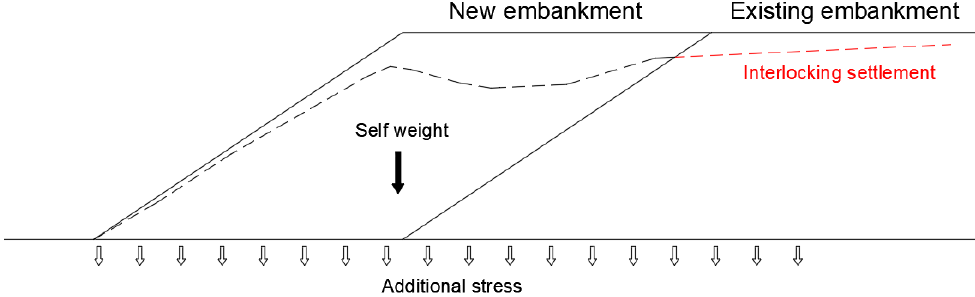
Figure 1. Concept drawing of interlocking settlements.